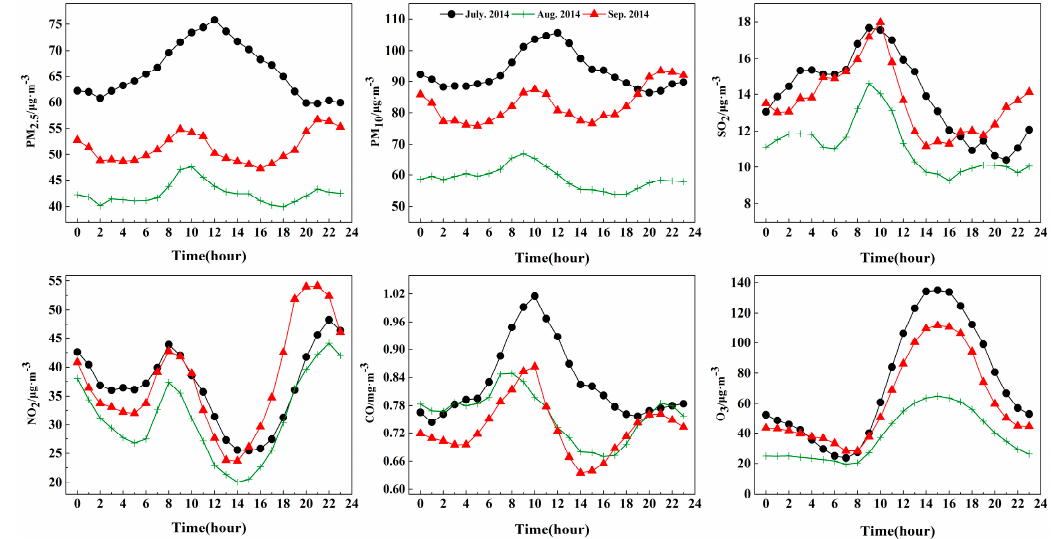
Figure 3. Diurnal variation of air pollutant concentrations in different periods.